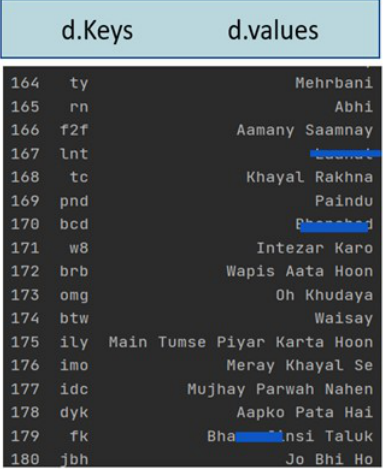
Figure 6. Slang and contractions in Roman